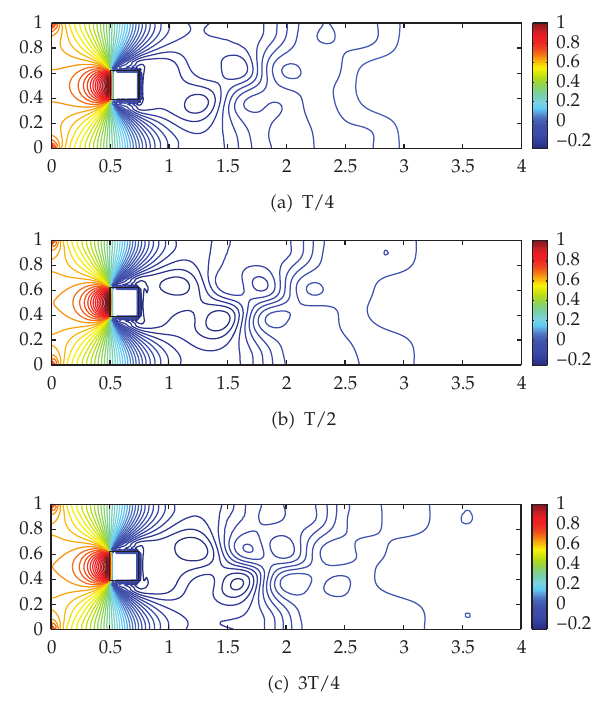
Figure 8: The pressure contours for flow field from 48 × 160 element grid and Δ t (cid:9) 0 . 01s time step at Re (cid:9)